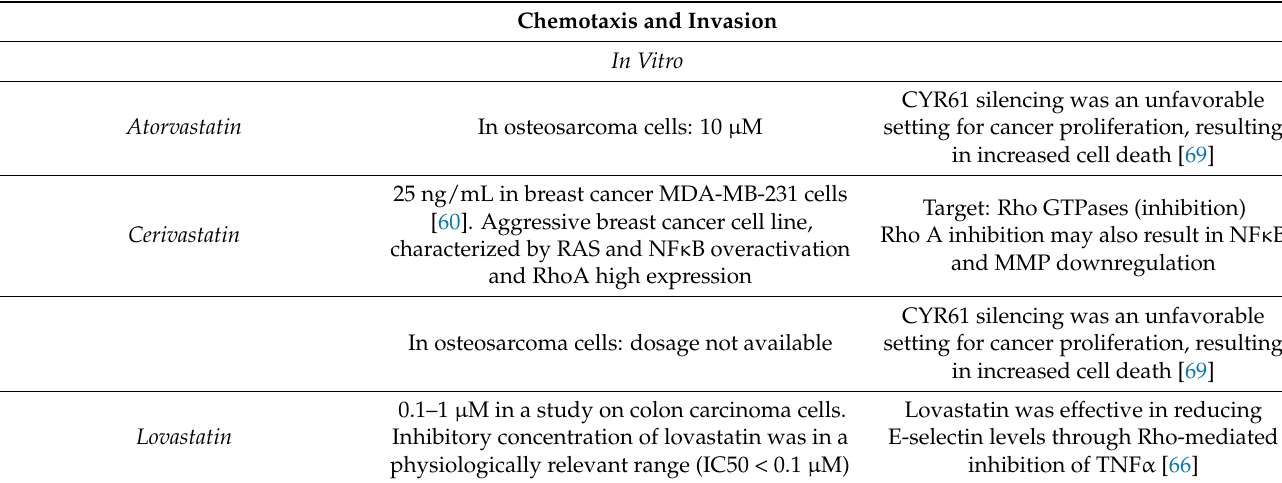
Table 6. Statins’ actions on chemotaxis, invasion and